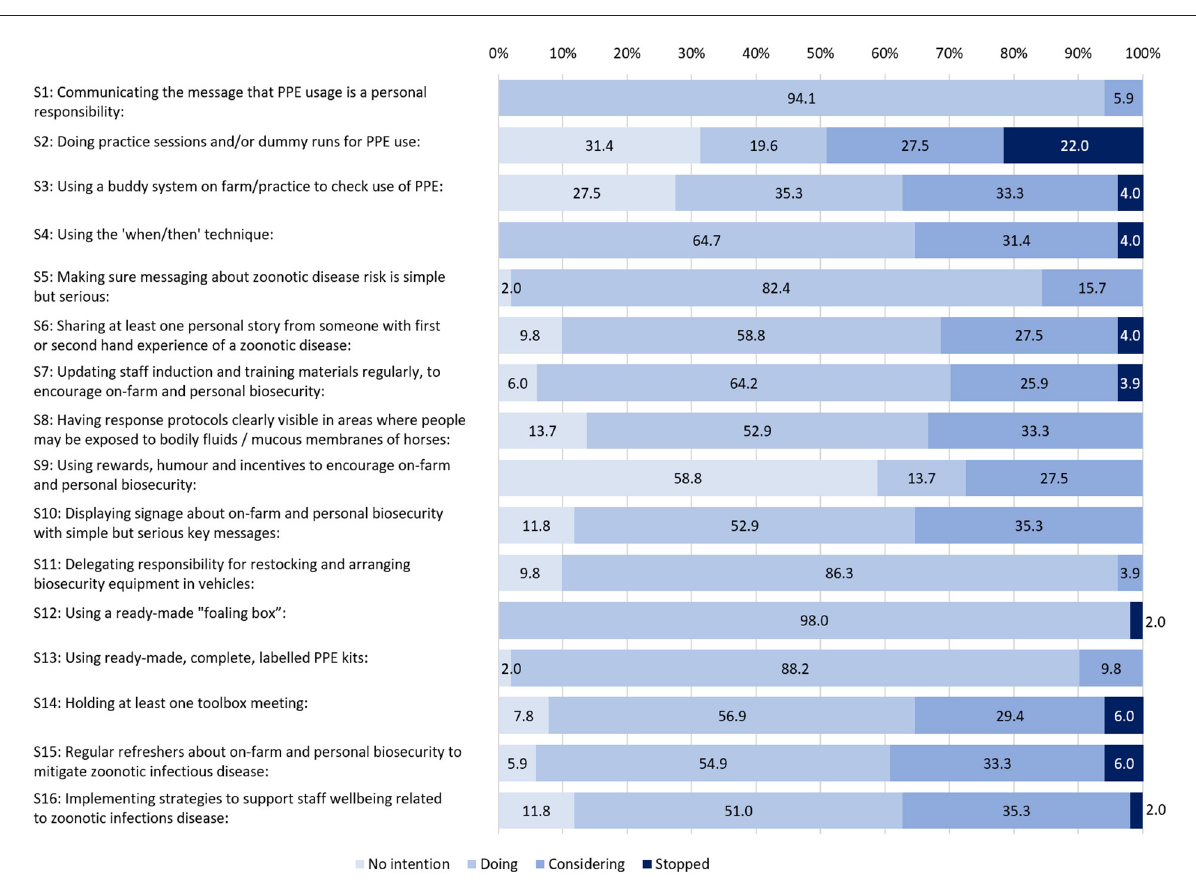
Buddy system not so relevant because they are all experienced. It is more so only relevant for newbies.